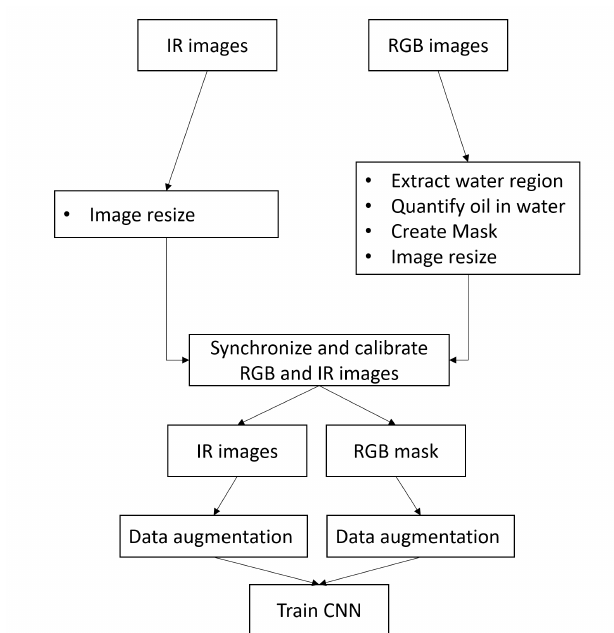
Figure 1. Flow chart of the training process.